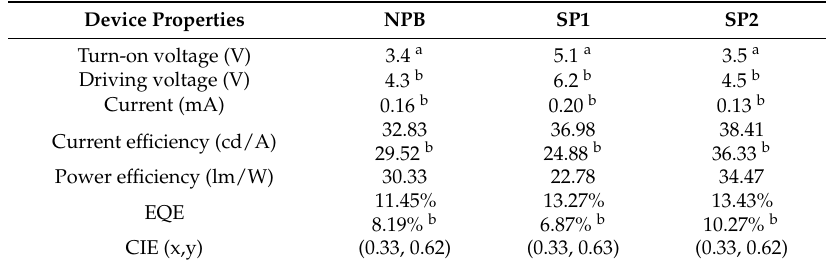
Table 2. Device characteristics of diphenylacridine (SP1) and phenothiazine (SP2). 4,4′-bis( N -phenyl- 1-naphthylamino)biphenyl (NPB).